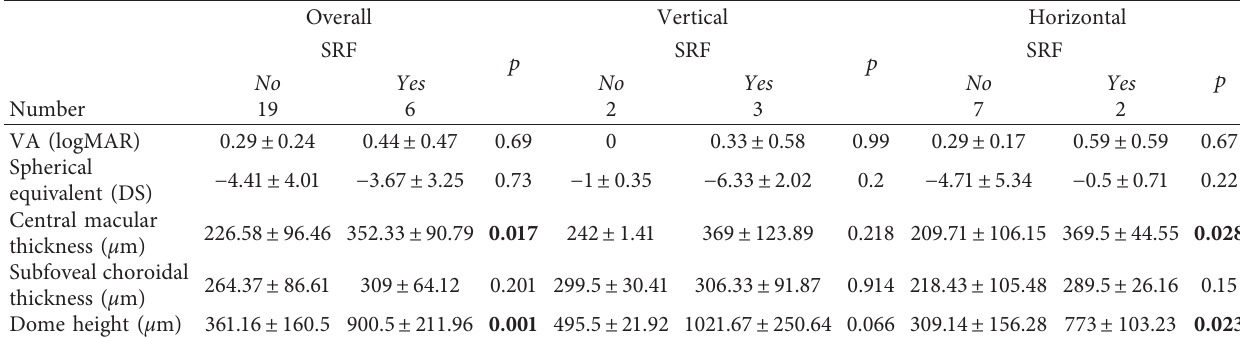
Table 3: Impact of SRF on morphological and functional parameters.